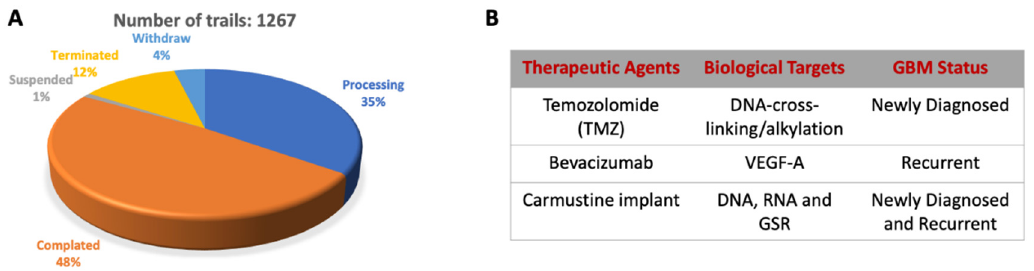
Figure 1. Clinical trials status and current therapeutic agents for GBM. ( A ) The total number of clinical trials for GBM is 1267. ( B ) Approved therapeutic agents used for the GBM treatment.